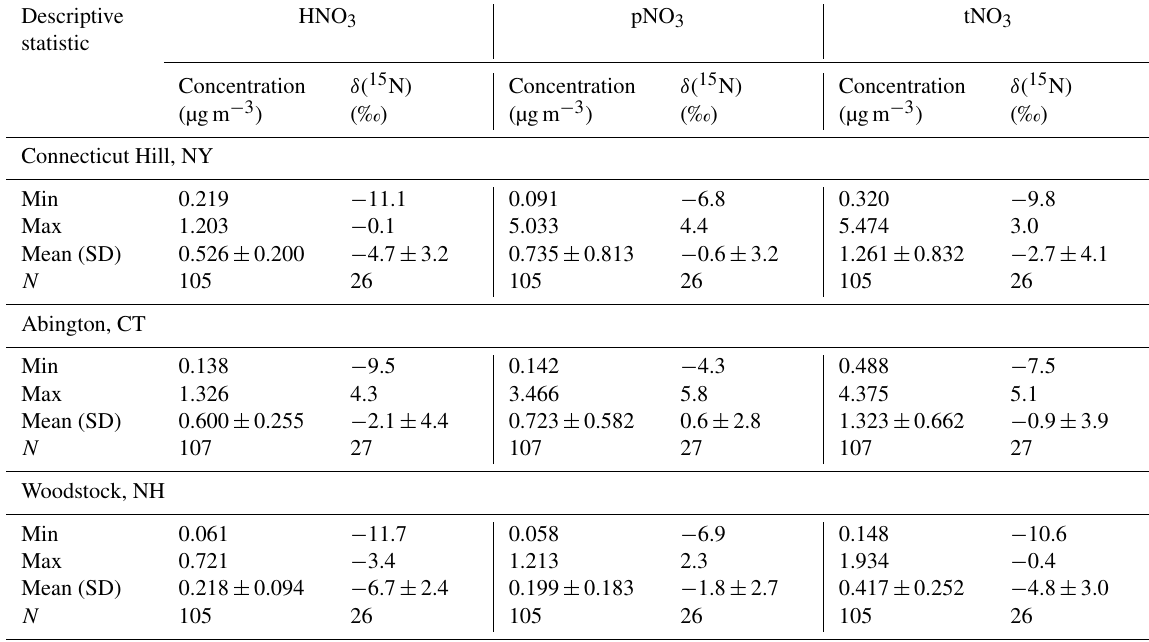
Table 2. Statistical summary including minimum (Min), maximum (Max), mean (Mean), standard deviation (SD), and number of counts ( N ) for concentration and δ ( 15 N) of HNO 3 , pNO 3 , and tNO 3 at the CASTNET